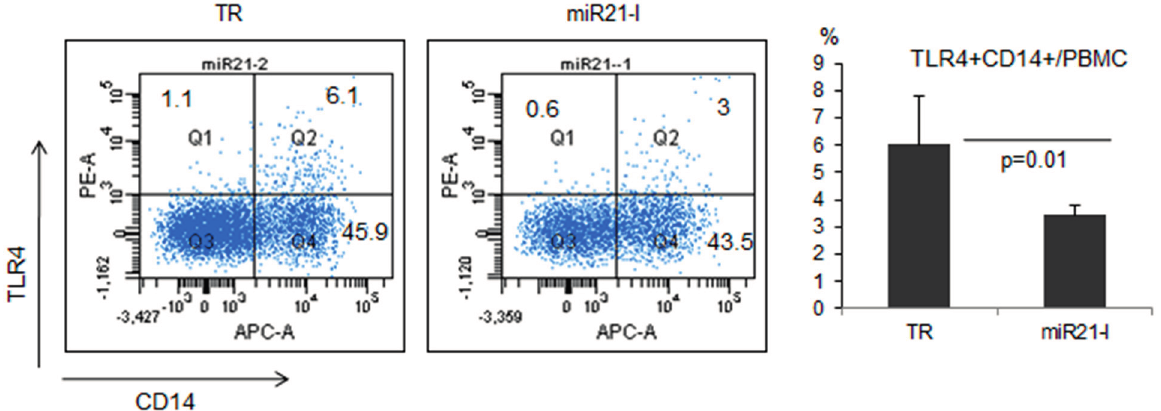
Figure 5. The frequencies of toll-like receptor (TLR)-4 positive cells were down-regulated after miR-21 inhibition by treatment of miR-21 antagomir in